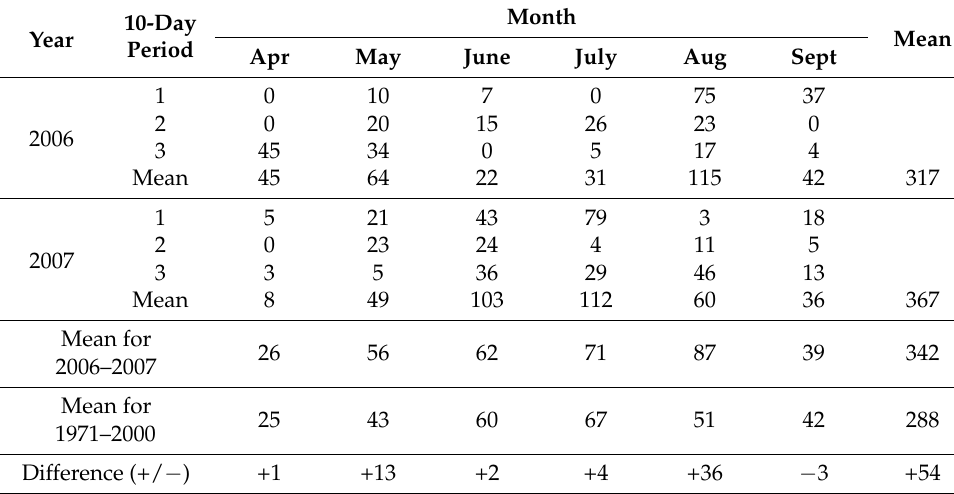
Table 4. Rainfalls (mm) in the 2006–2007 vegetation season.